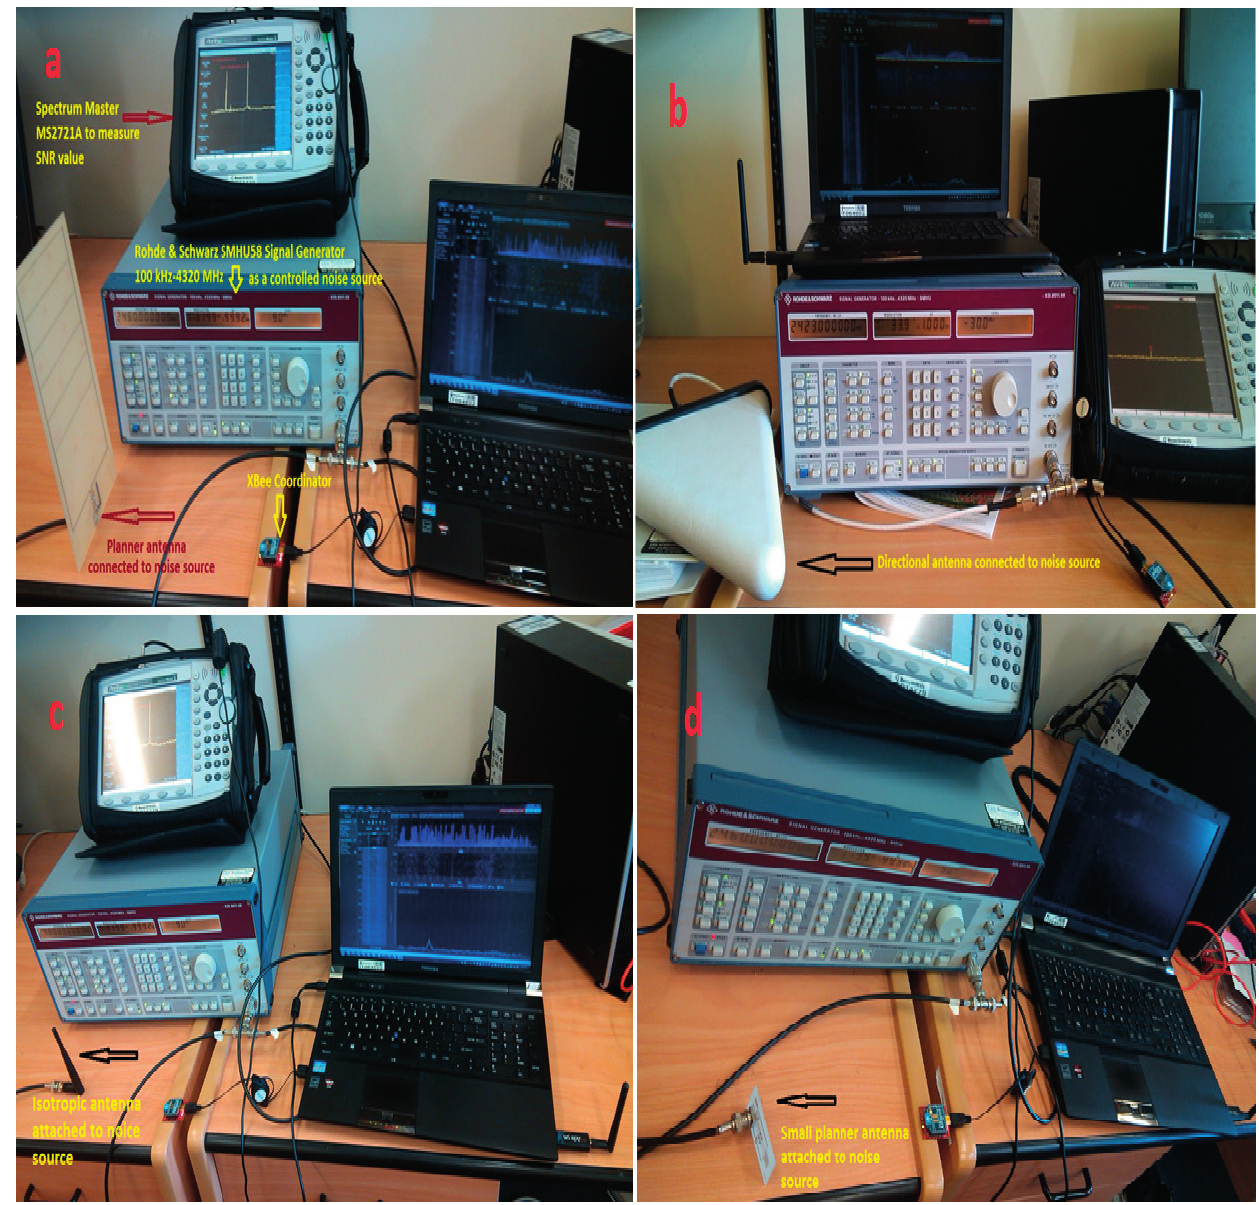
Figure 18. Controlled noise setup to investigate the interference characteristics of the smart building environment; ( a ) External noise generated by planner antenna; ( b ) External noise generated by directional antenna; ( c ) External noise generated by isotropic antenna and ( d ) External noise generated by small planner